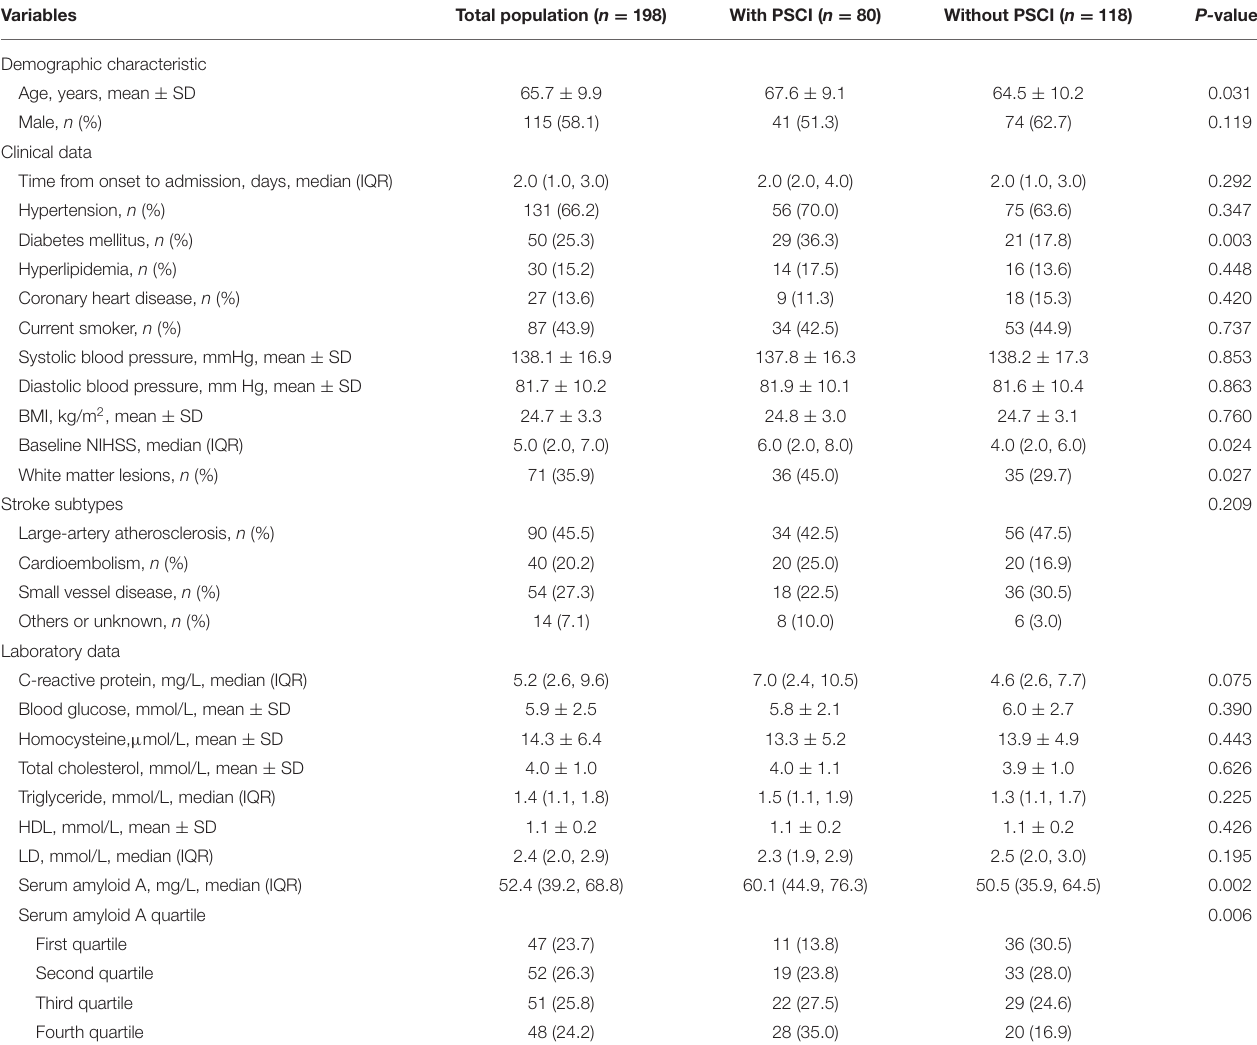
TABLE 1 | Baseline data according to patients with and without cognitive impairment.